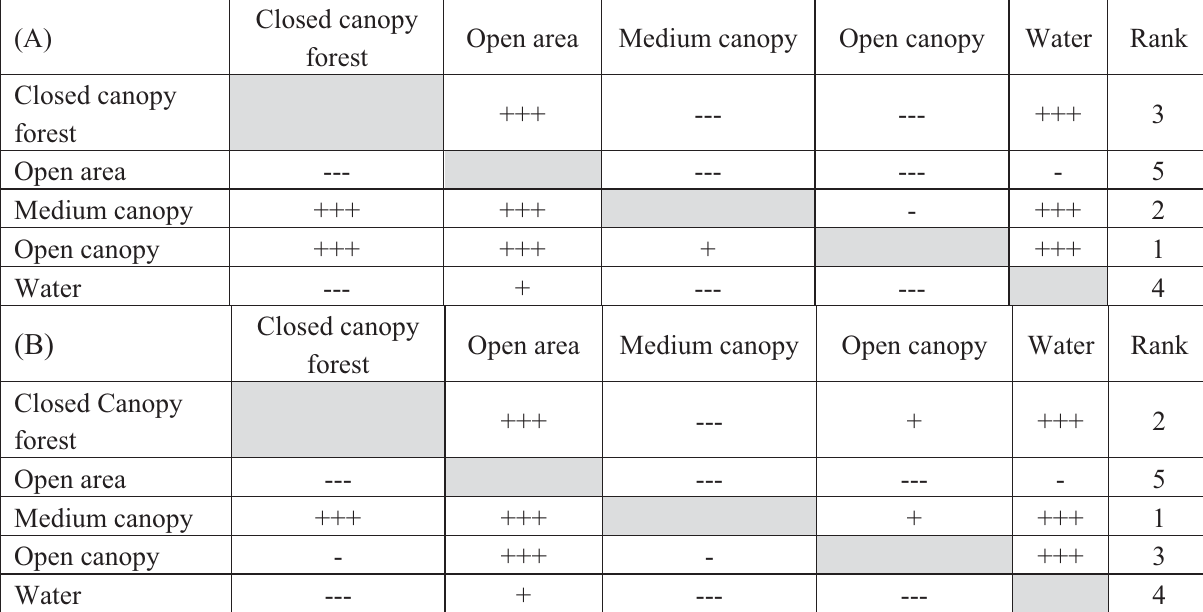
Table 3. Nocturnal ( A ) and diurnal ( B ) habitat ranking matrix using 3rd order compositional analyses for five habitats (bold) used by an adult, female elephant from August 25, 2007–May 14, 2008, at Seblat, Bengkulu, Sumatra.